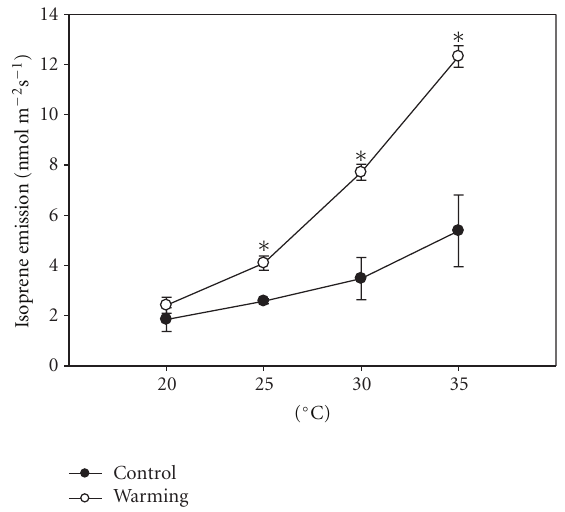
Figure 2: Relationship between isoprene emission rate and leaf temperature, ± S.E of Phragmites australis grown in a hydroponic system with water at di ff erent temperatures. ∗ P ≤ 0 . 05, ∗∗ P ≤ 0 . 01, ∗∗∗ P ≤ 0 . 001.